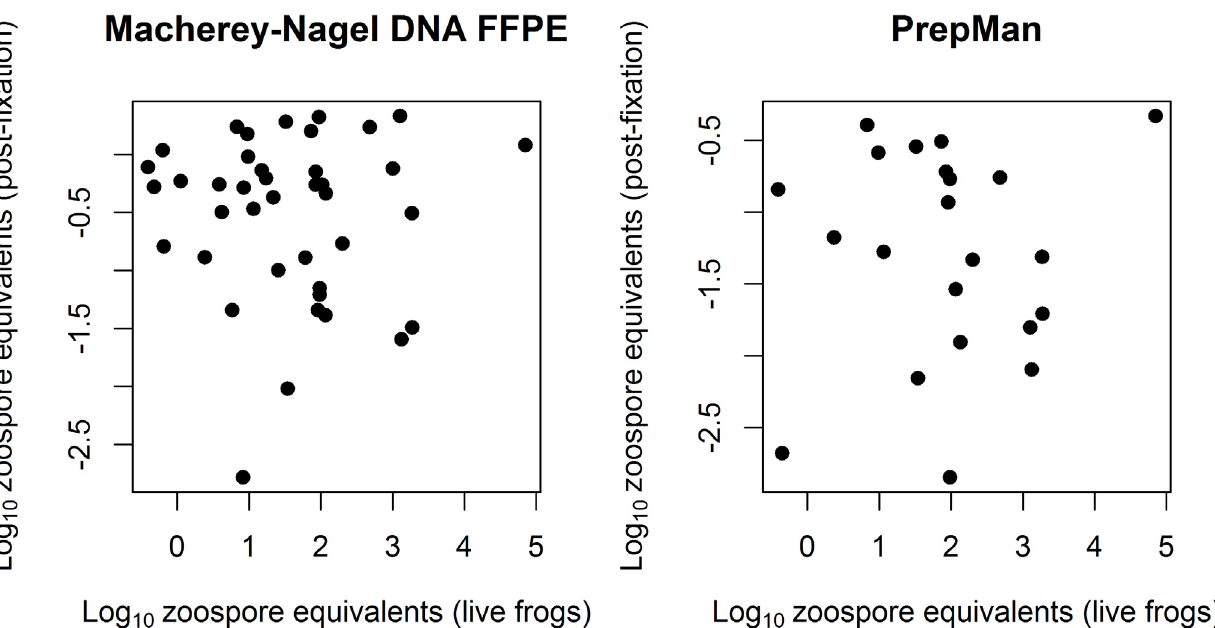
Fig 3. Nonzero zoospore equivalent values before and after formalin fixation for MN and PM-extracted swabs. There was no significant relationship between pre-and post-preservation Bd loads on individual swabs for either the MN (R 2 = 0.0006; R 2 (adj.) = -0.026; p = 0.879) or the PM (R 2 = 0.003; R 2 (adj.) = -0.046; p = 0.798) extracted specimen